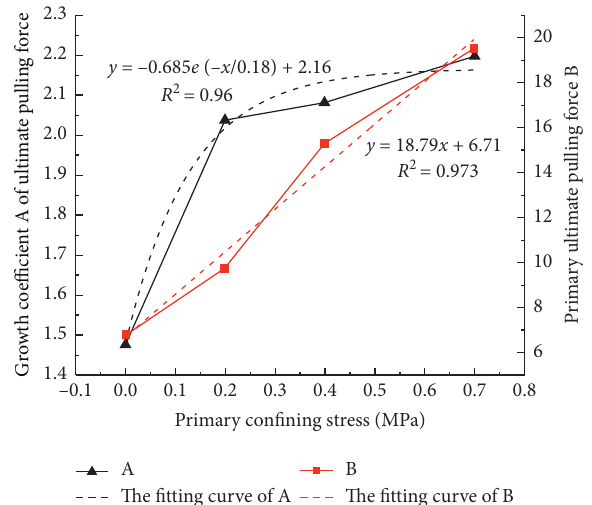
Figure 19: Relationship curves between the ultimate pull-out force growth factors. (a) The initial ultimate pull-out force. (b) The initial limit.